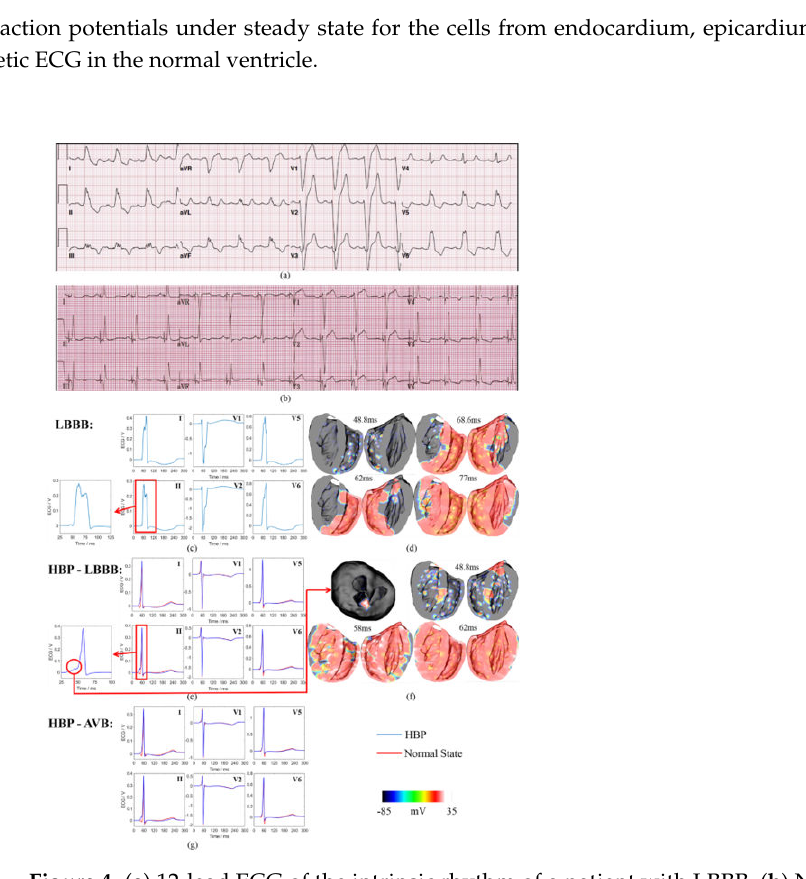
Figure 4. ( a ) 12-lead ECG of the intrinsic rhythm of a patient with LBBB. ( b ) NSHBP corrected the LBBB pattern in the patient. ( c ) Synthetic ECG of simulated LBBB. ( d ) Activation sequences at several specific moments in simulated LBBB. ( e ) Synthetic ECG under simulated HBP (blue line), compared with that of normal state (red line). ( f ) Activation sequences at several specific moments in the simulation of HBP correcting LBBB. ( g ) Synthetic ECG of simulated HBP correcting AVB (blue line), compared with synthetic ECG of normal state simulation (red line). LBBB: left bundle branch block. NSHBP: Non-selective His-bundle pacing. HBP: His-bundle pacing. AVB: atrioventricular